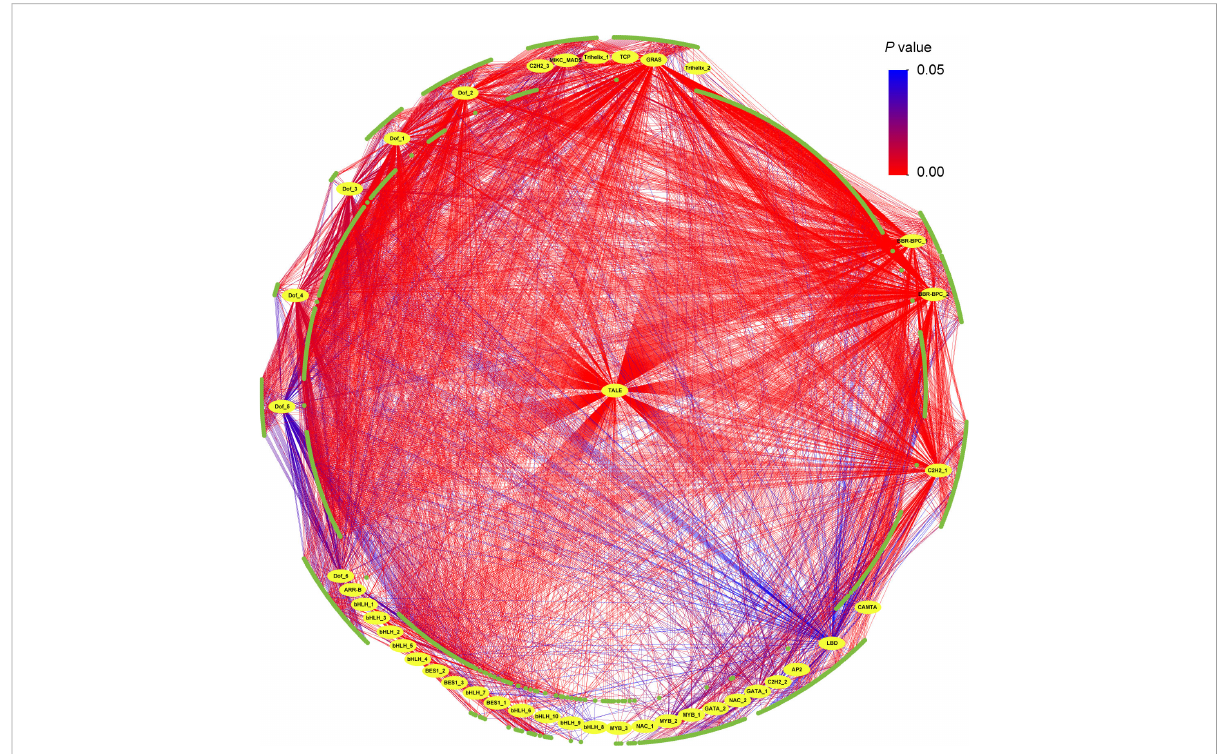
FIGURE 5 Transcription factor (TF) predicted in candidate genes. Yellow circles are 41 signi fi cant TFs and green circles are 944 candidate genes. The color of the line represents the P value. Details of TFs are shown in Table